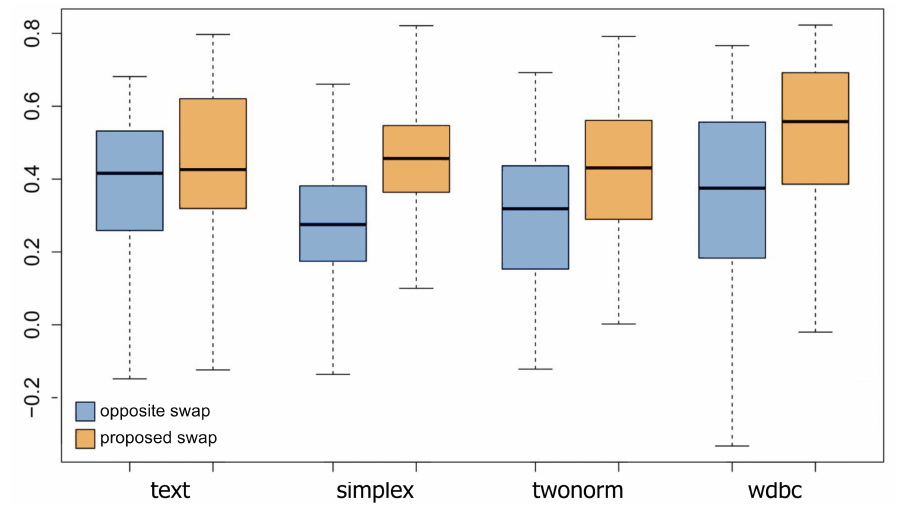
Figure 4. Boxplots summarizing the results obtained by the proposed H-Tree swap